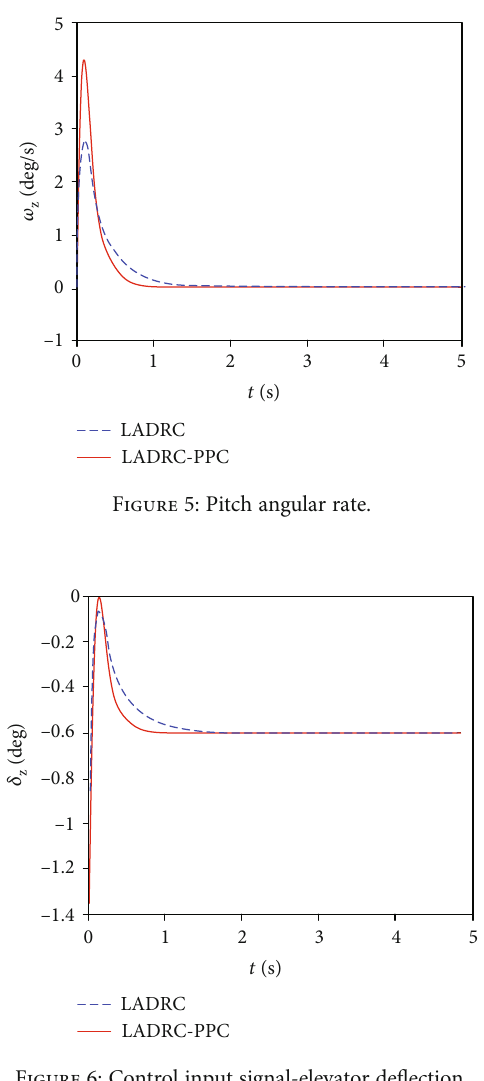
Figure 6: Control input signal-elevator de fl ection.